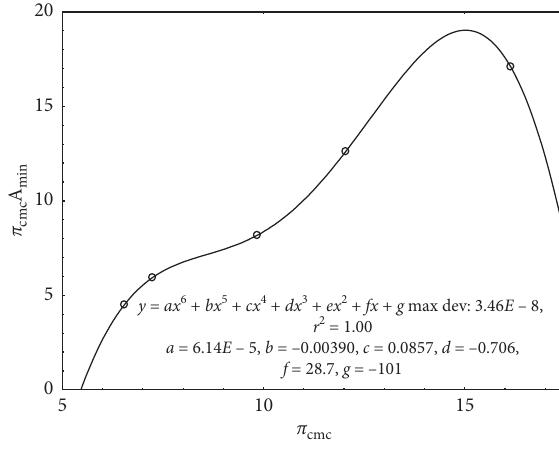
Figure 14: Variation of π